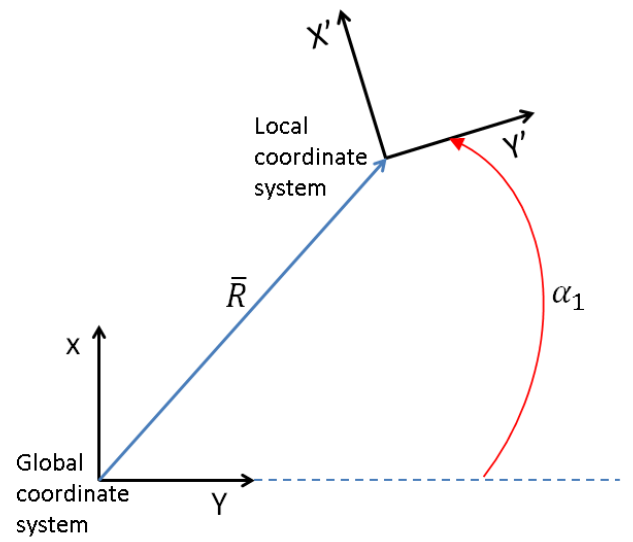
Figure 3. Global and local coordinate systems. In this analysis, the origin of the global coordinate system is at C.G. and the origin of the local system is at the connection point of the side-hull, as presented in Figure 2.